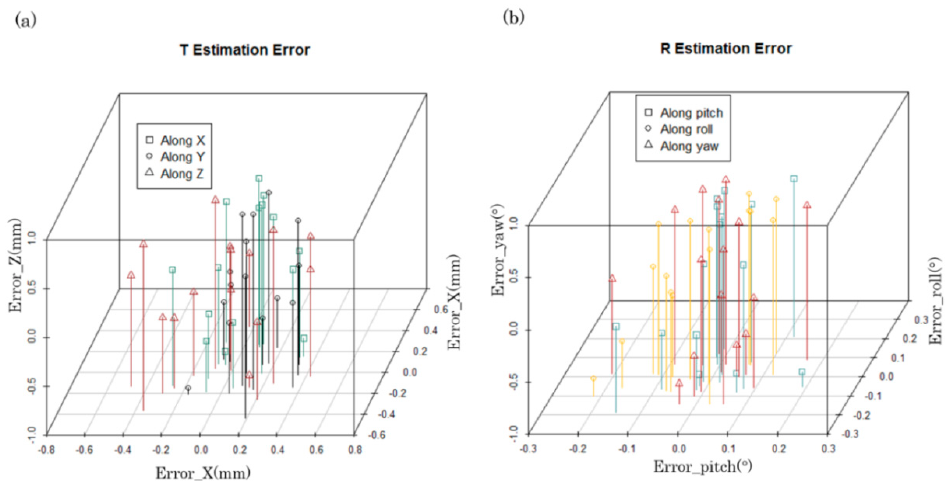
Figure 11. Experimental results of the estimation error in 3D coordinates; ( a ) Errors in translation vector T ; ( b ) Errors in rotation matrix R , which can be defined by the three angles: θ (roll), φ (pitch), ψ (yaw).